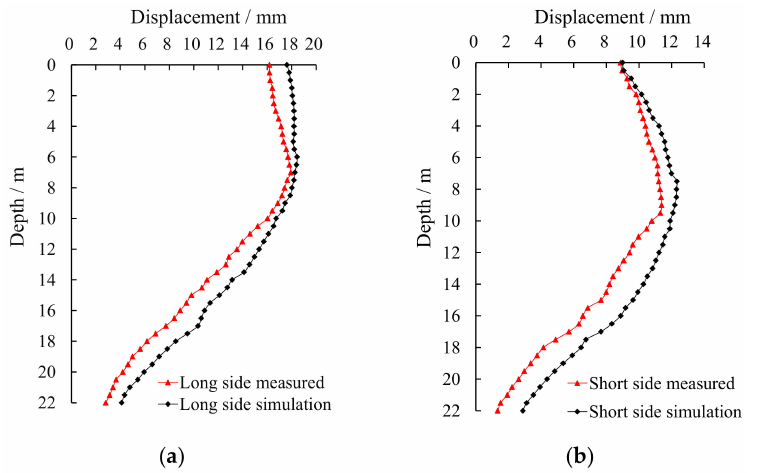
Figure 15. Horizontal displacement of piles at various depths: ( a ) HH section of the long side, ( b ) KK section of the short